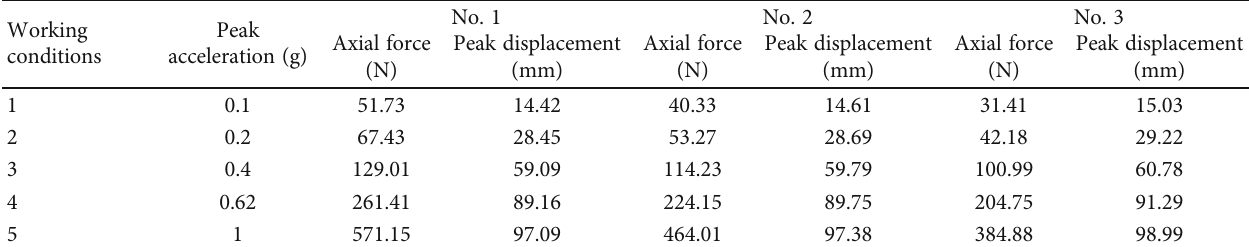
Figure 7: Peak axial force of the anchor cable under di ff erent working conditions. Table 2: Axial force and peak displacement of anchor piles under di ff erent working